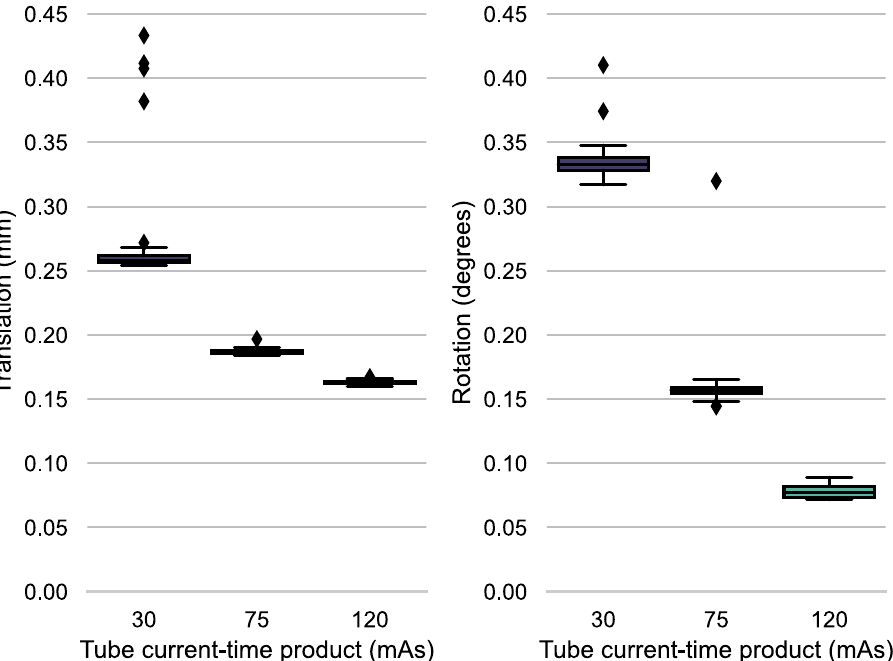
Figure 4. SNR induced error: The error in registration at different levels of tube current-time product, leading to different SNR’s. The translational error in mm is shown in the left subgraph, while the rotational error in degrees is given by the right subgraph. All boxplots in this study show the median (horizontal line), interquartile range (IQR) (box), values within the range Q1-1.5*IQR to Q3+1.5*IQR (whiskers) and values outside of the previous range (outliers). Imaging technique: